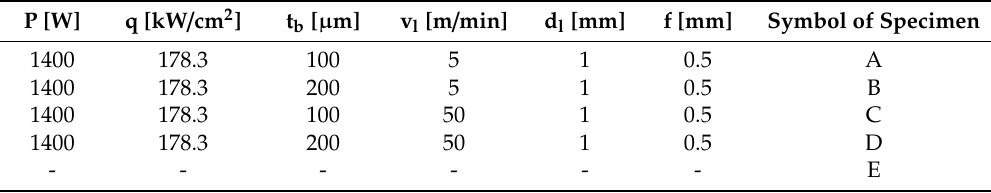
Table 3. Laser alloying